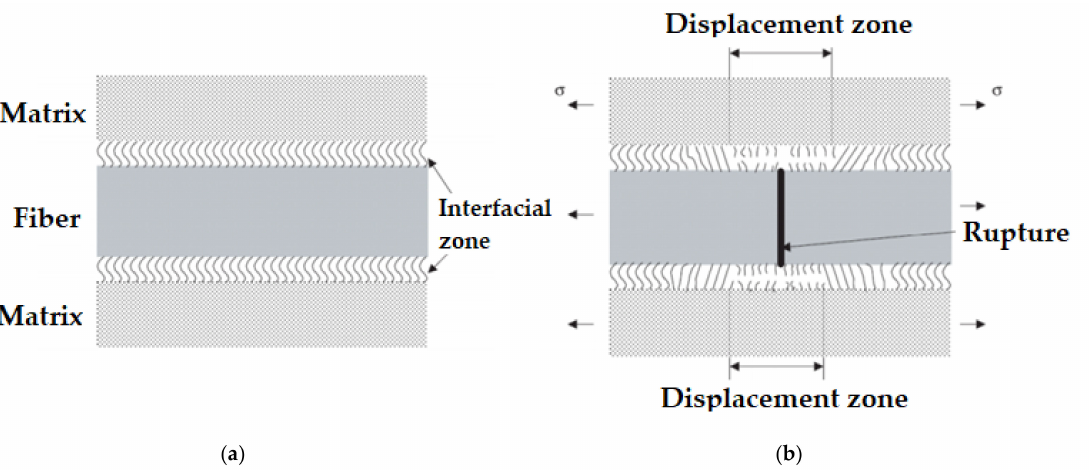
Figure 4. Schematic of the microstructure of the fiber–matrix interface: ( a ) before load application and without fiber breakage; ( b ) after application of the load, with fiber